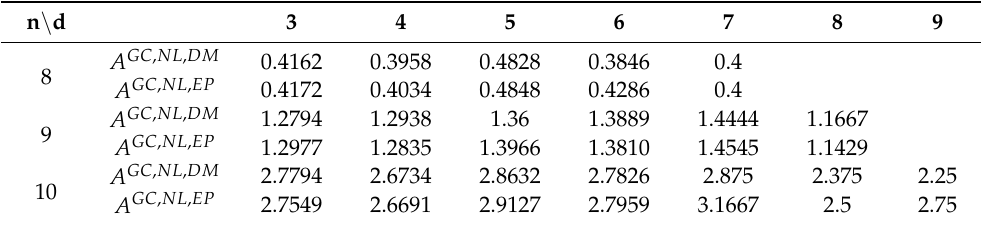
Table 12. Comparison results for the hairpin structure ratio.